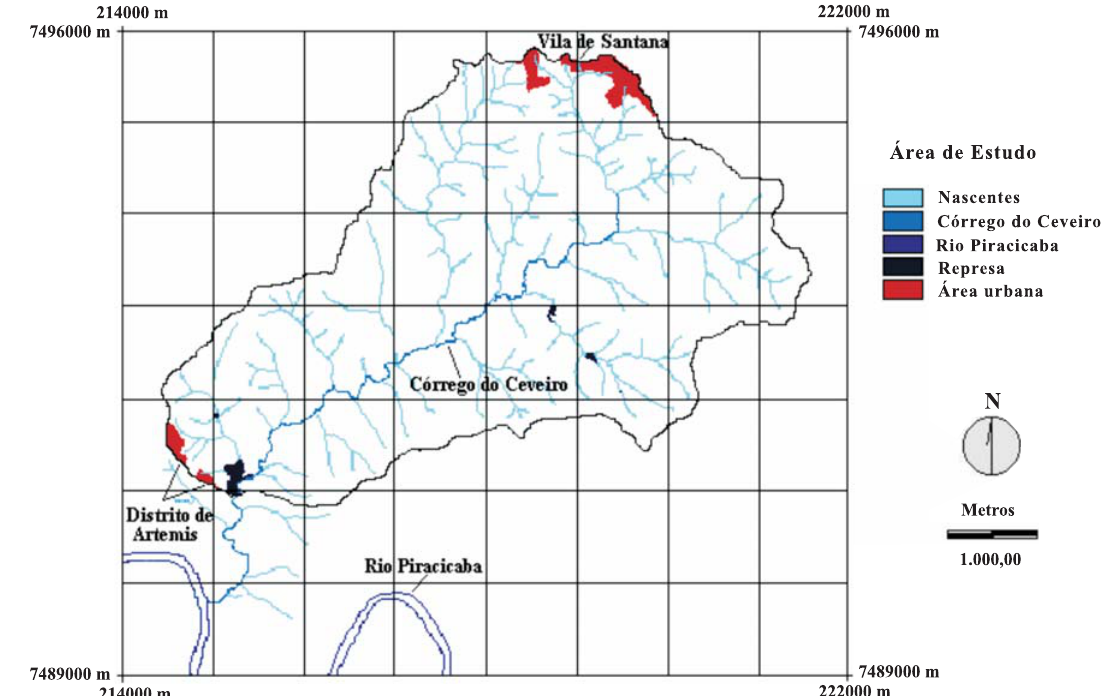
Figura 1. Área de estudo: limites, área urbana e